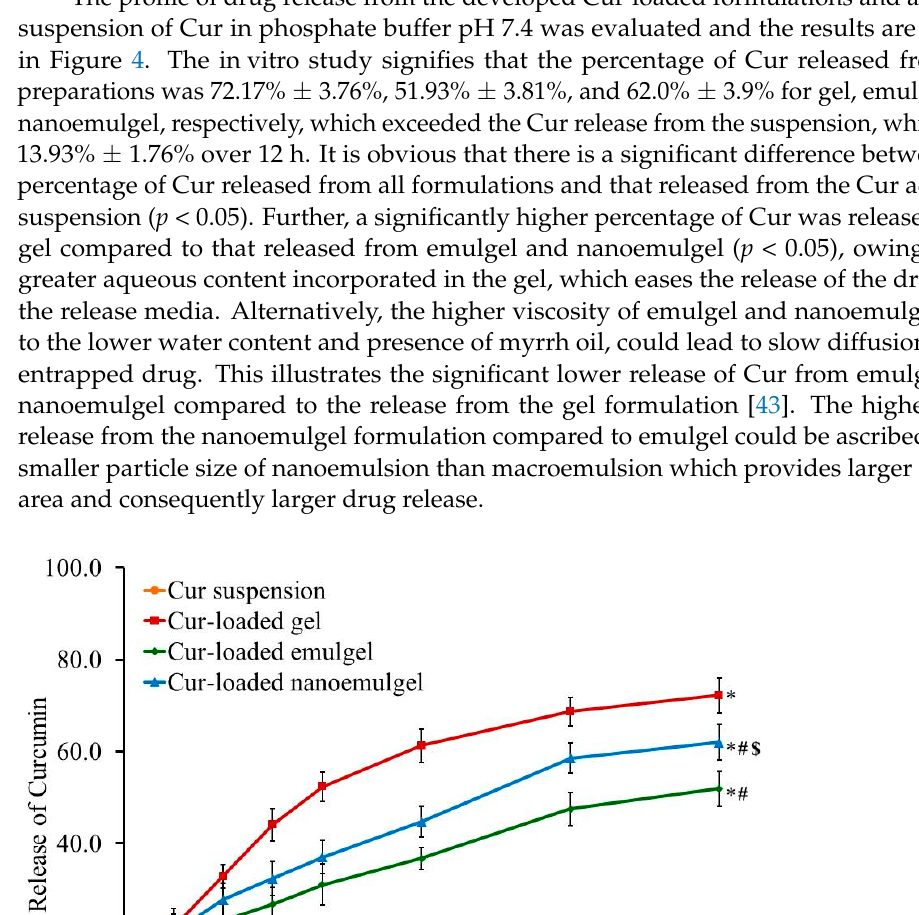
Table 3. Release kinetics of different Cur-loaded formulations.